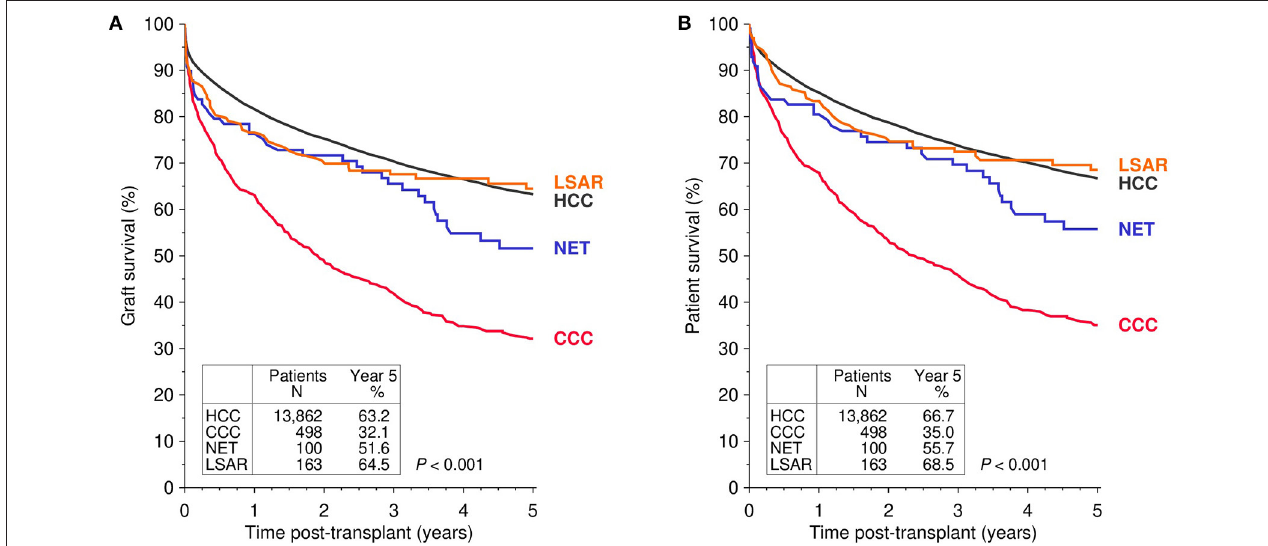
FIGURE 1 | Kaplan-Meier analysis of graft (A) and patient survival (B) in first deceased donor liver transplants performed in patients with different pre-transplant malignancies that led to transplantation. The global log-rank P-value is shown. HCC, hepatocellular carcinoma; CCC, cholangiocellular carcinoma; NET, neuroendocrine tumor; LSAR, sarcomas of the liver.